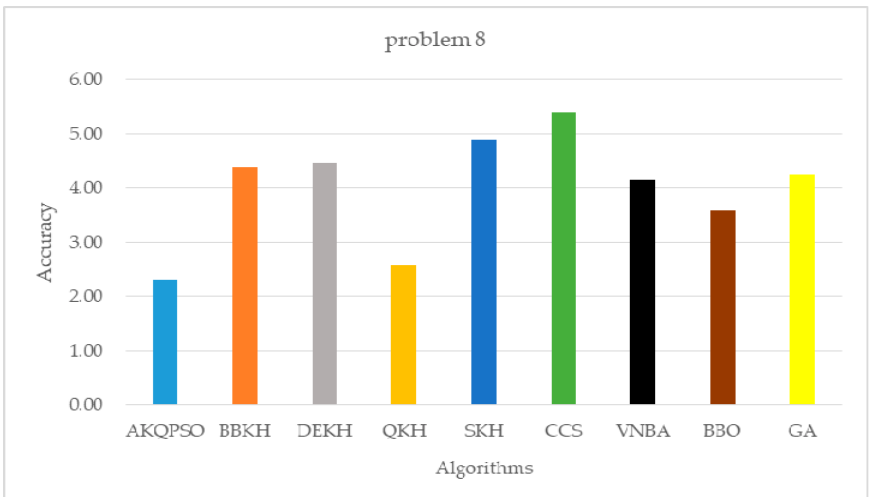
Figure 10. Accuracy of AKQPSO and other algorithms on problem 8: expanded Schaffer’s F6 function.